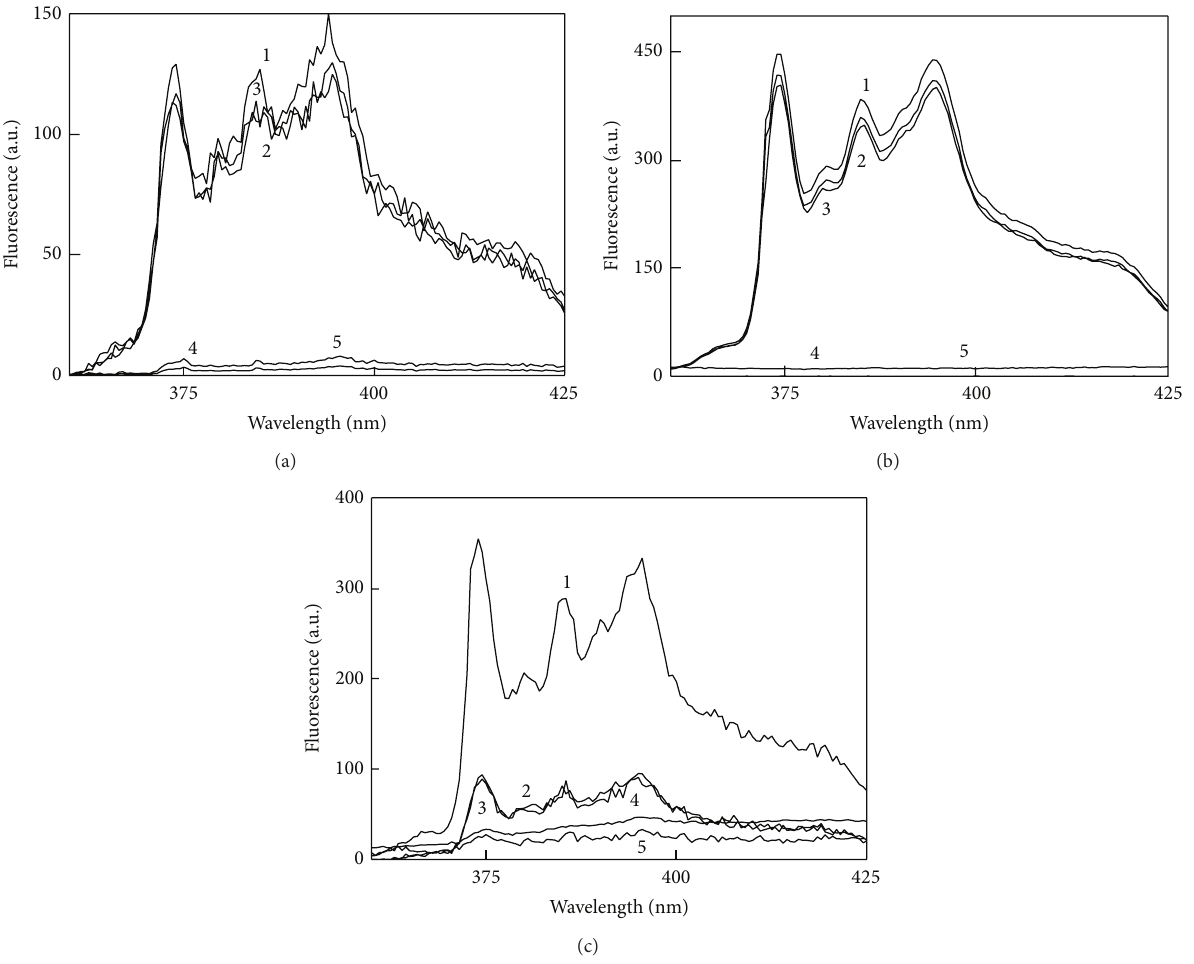
Figure 6: Fluorescence spectra of pyrene ( 𝜆 sorption; after sorption on the CTS fiber, (2) polybasic and (3) polycationic forms; and on the CTS fiber, (4) polybasic and (5) polycationic